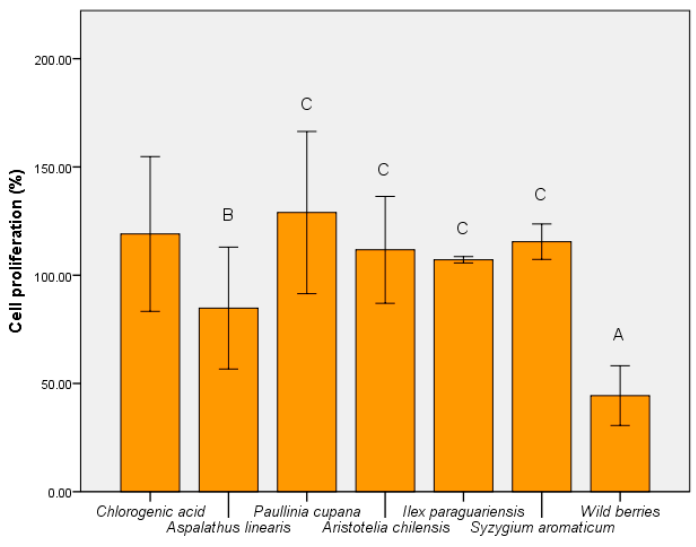
Figure 8. MTT assay of S. boulardii cells cultivated in the presence of hydroalcoholic extracts. Different letters represent significant statistical differences (chlorogenic acid vs. samples; p ≤ 0.05), n = 3; chlorogenic acid was used as control.